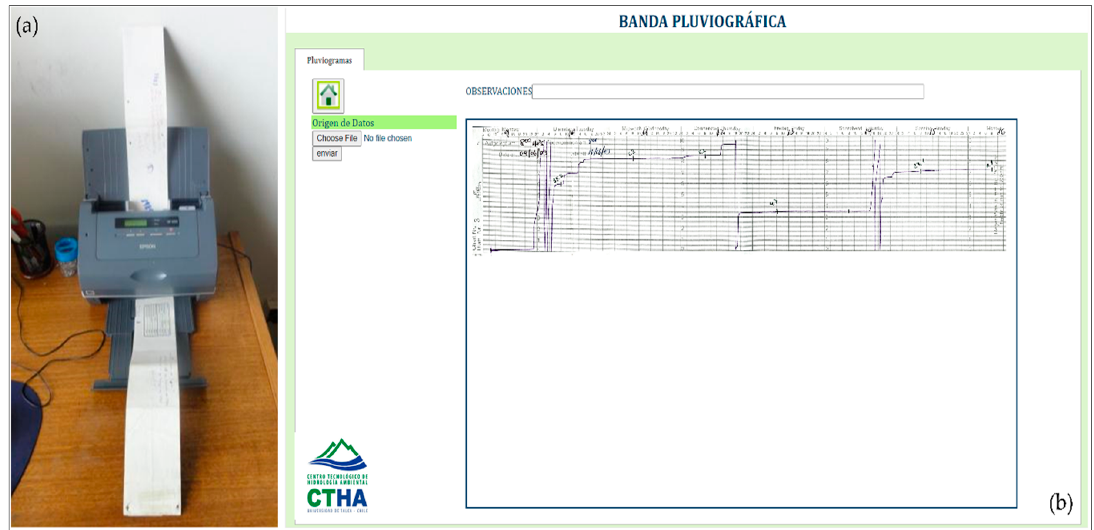
Figure 5. The equipment for digitization of pluviograph bands includes ( a ) a digitizer Epson Workforce Pro GT-S50 and ( b ) a graphical interface to process acquired images to